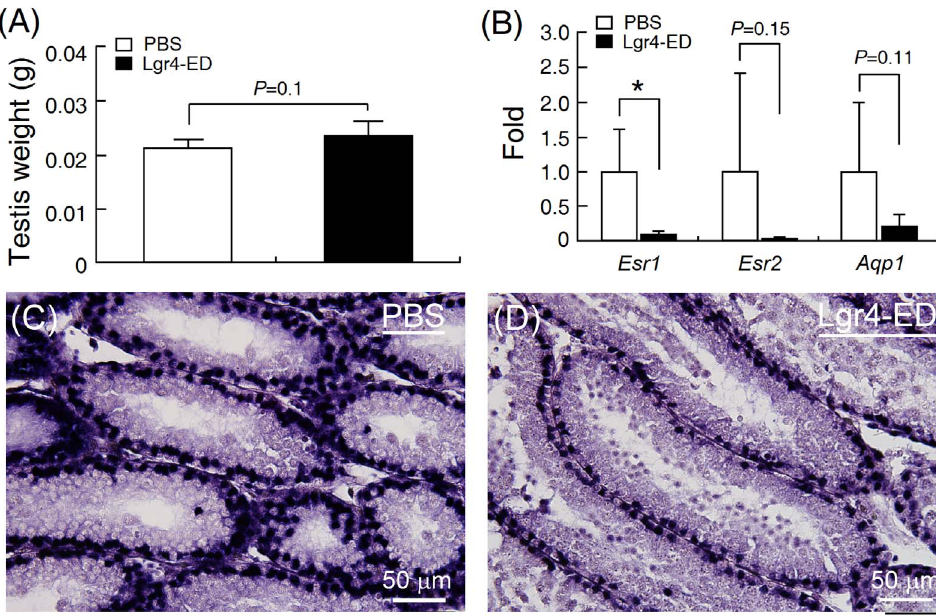
Figure 6. The recombinant Lgr4-ED protein affects postnatal development of the testis. Neonatal male mice were injected intraperitoneally with either controlled saline or purified recombinant Lgr4-ED (10 m g/animal) on postnatal day 1, 8 and 15. Mice were then sacrificed on day 22 and (A) the testicular weights were measured. (B) The expression levels of Esr1, Esr2, Aqp1 in the harvested testes were compared by real- time PCR. Data were normalized against b -actin levels and represent the mean 6 SEM (n=6). Asterisks indicate P , 0.05. (C and D) In addition, the testes were also subjected to immunohistochemical staining to detect the Esr1 protein and visualized using an alkaline phosphatase staining system.